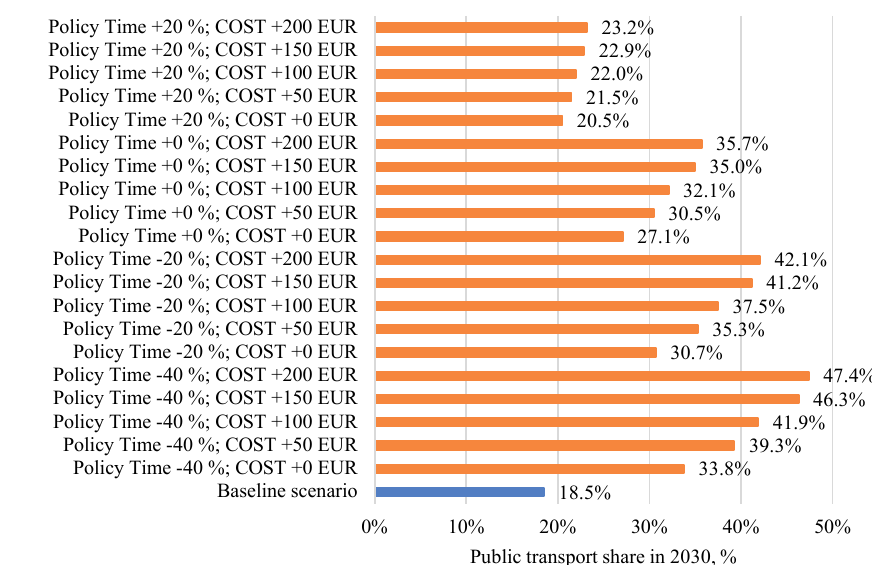
Fig. 6. The total effect on public transport share in 2030 (Both matters